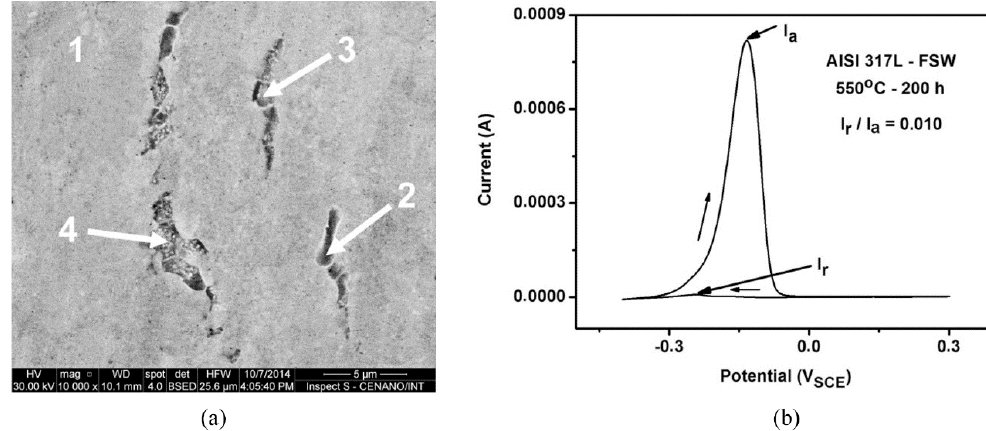
Figure 3. (a) Microstructure and (b) DL-EPR curve of specimen aged at 550 °C for 200